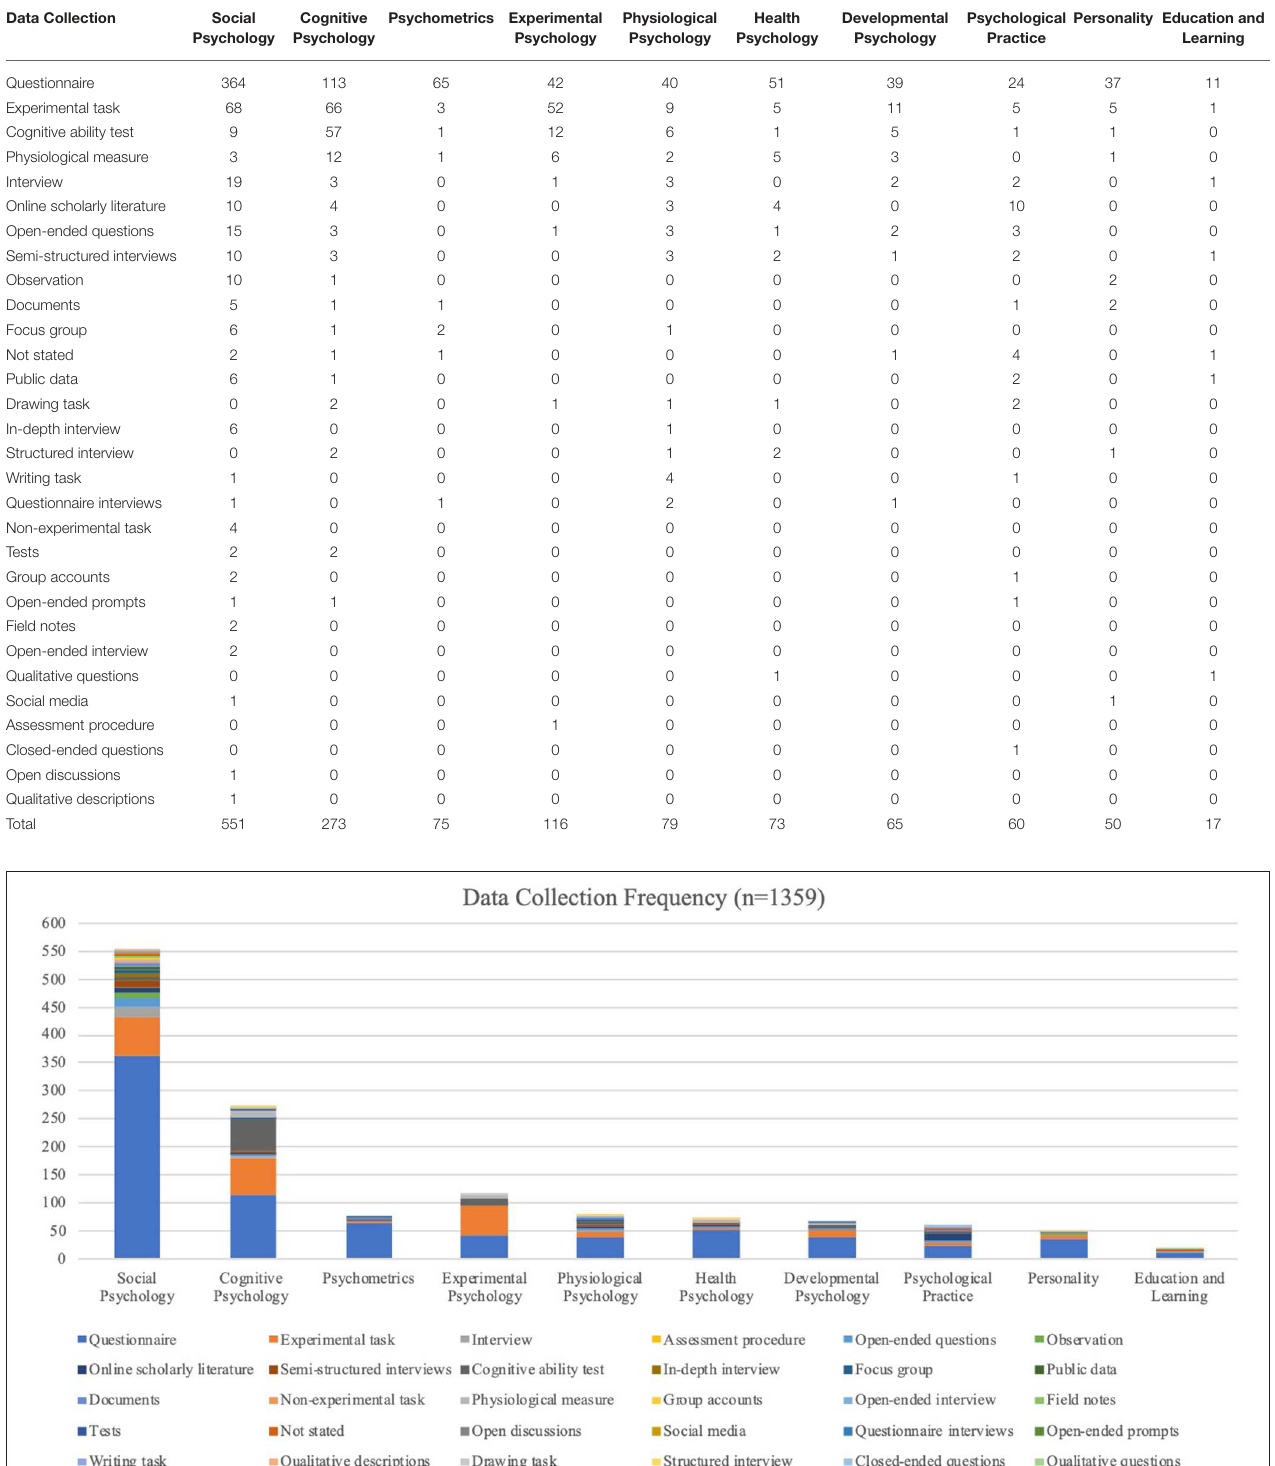
TABLE 5 | Data collection in the field of psychology. Data Collection